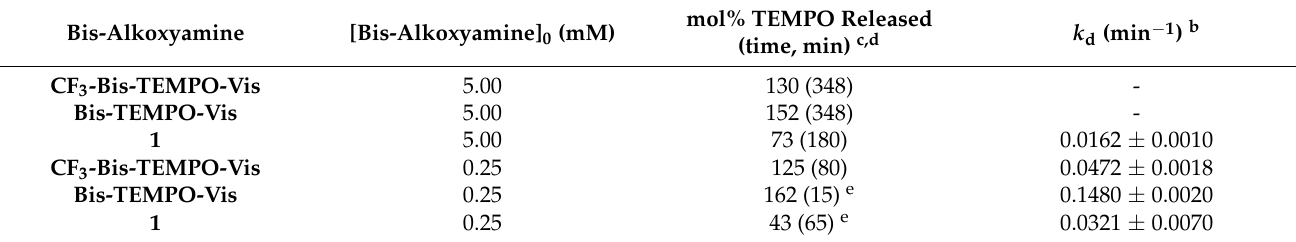
Table 1. Kinetics of Bis-Alkoxyamine Homolysis a .